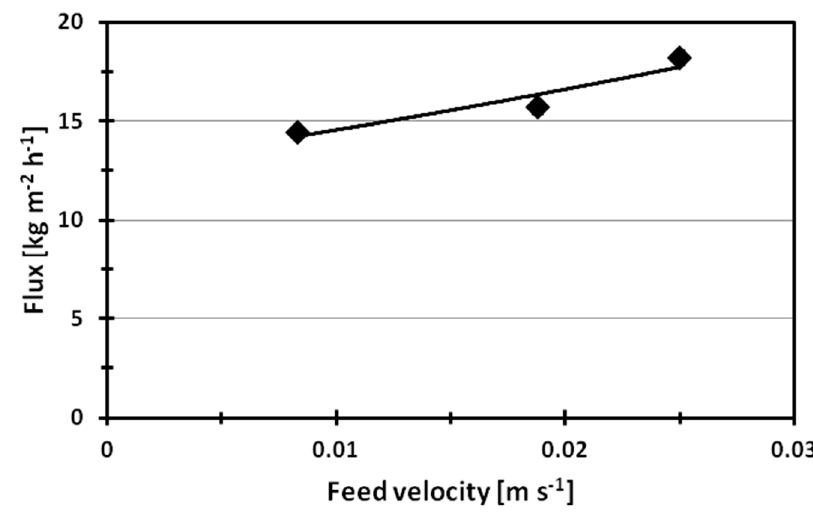
Figure 6. Effect of the feed velocity on the flux of PVDF ENM in DCMD process at a feed temperature of 60 °C.